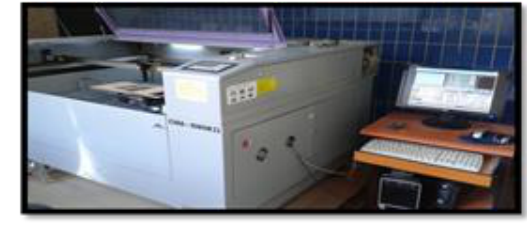
laser treatment . 2